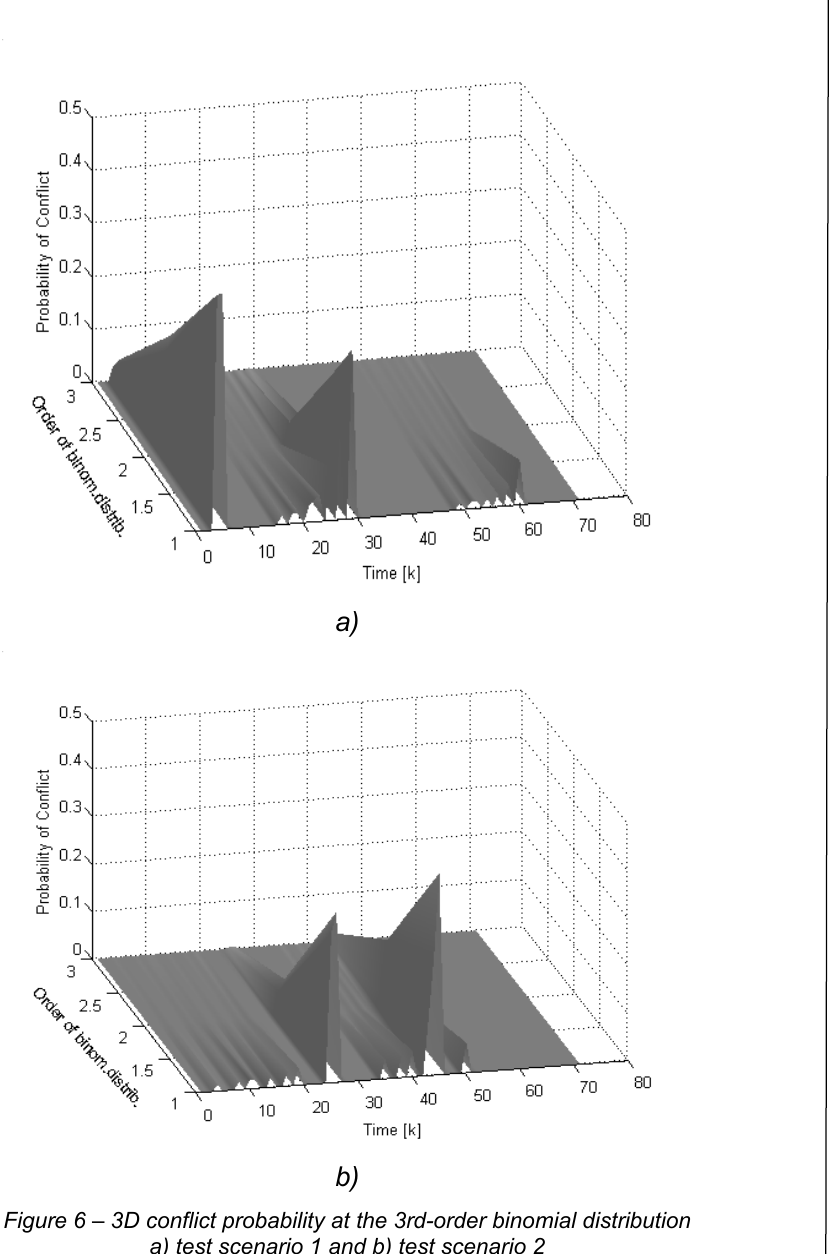
Figure 6 – 3D conflict probability at the 3rd-order binomial